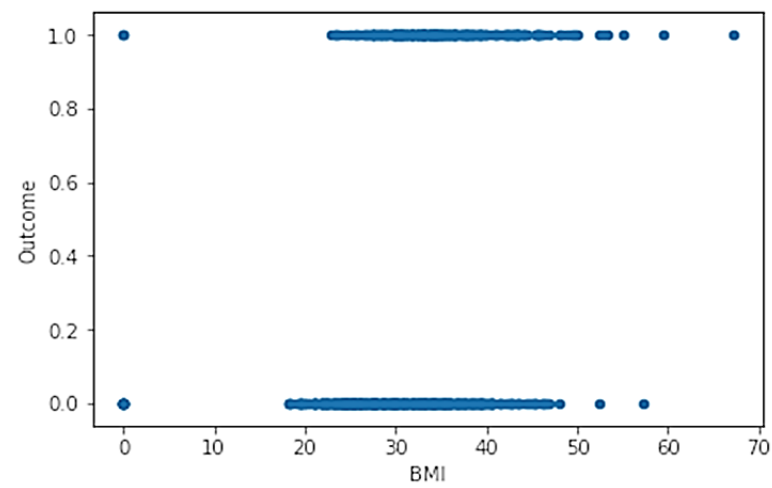
Figure 5. Outcome versus BMI function.